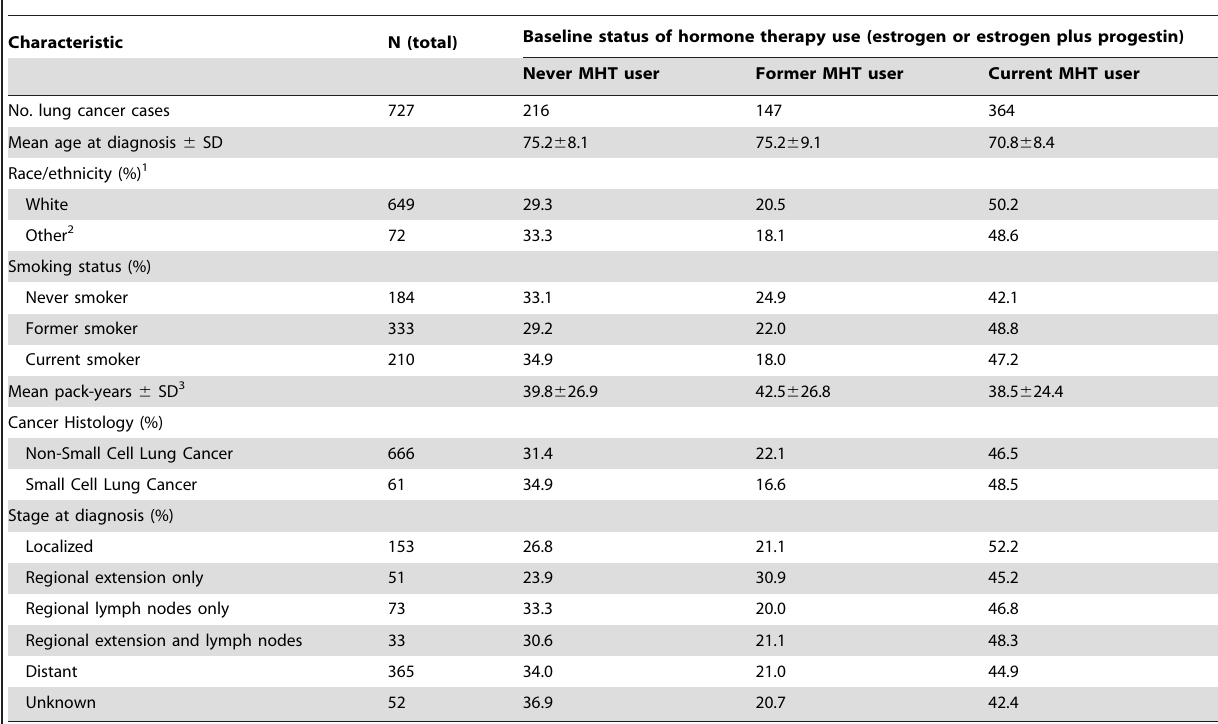
1 Race/ethnicity analysis was not adjusted for by age. 2 Other category for race/ethnicity includes: African American, Hispanic, Native American, Asian/Pacific Islander, Mixed and Unknown. 3 Mean pack-years calculated only among ever smoking women. Figure 1). Whether MHT use was former or recent (current at baseline) did not modify the association (HR, 0.68, 95% CI, 0.49–